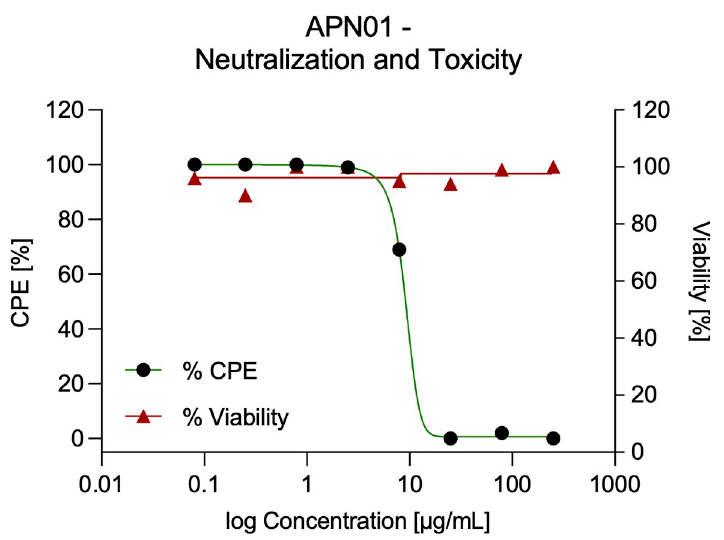
Fig 1. APN01 neutralization of SARS-CoV-2 in the absence of cytotoxicity. Serial dilutions of APN01 were prepared in assay medium (MEM supplemented with 2% fetal bovine serum and 50 μ g/mL gentamicin) and a suspension of SARS-CoV-2 (USA-WA1/2020) was added to assess neutralization. For assessment of APN01 on viability, assay medium without virus was added. After one-hour incubation at 37˚C, the dilutions were transferred to wells containing Vero E6 target cells (Multiplicity Of Infection, 0.001). Incubation was continued for four days and cell numbers were assessed with a neutral red endpoint. Cytopathic Effect (CPE) was calculated as the average optical density (OD) for replicate infected and treated wells divided by average control OD X 100 (expressed as a percentage). Viability was calculated as the average optical density for replicate uninfected and treated wells divided by average control OD X 100 (expressed as a